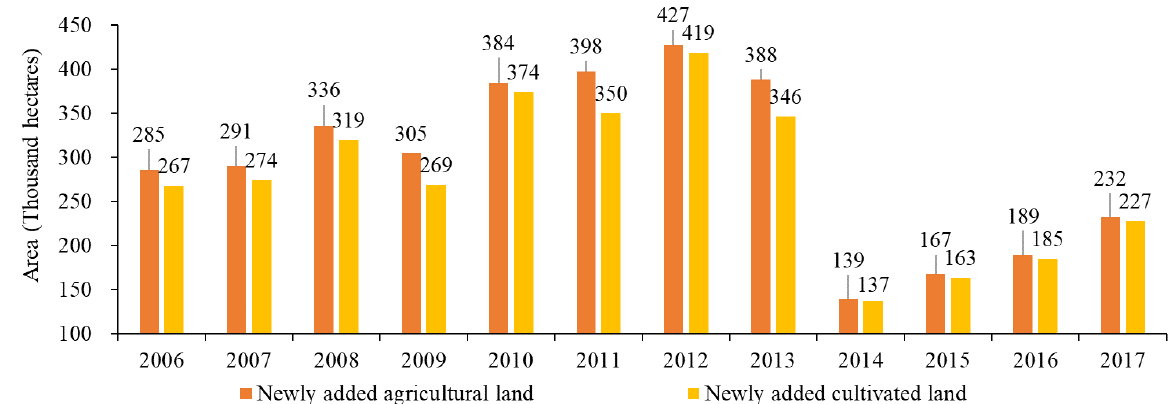
Figure 4. China’s newly added agricultural and cultivated land area through land consolidation in 2006–2017.